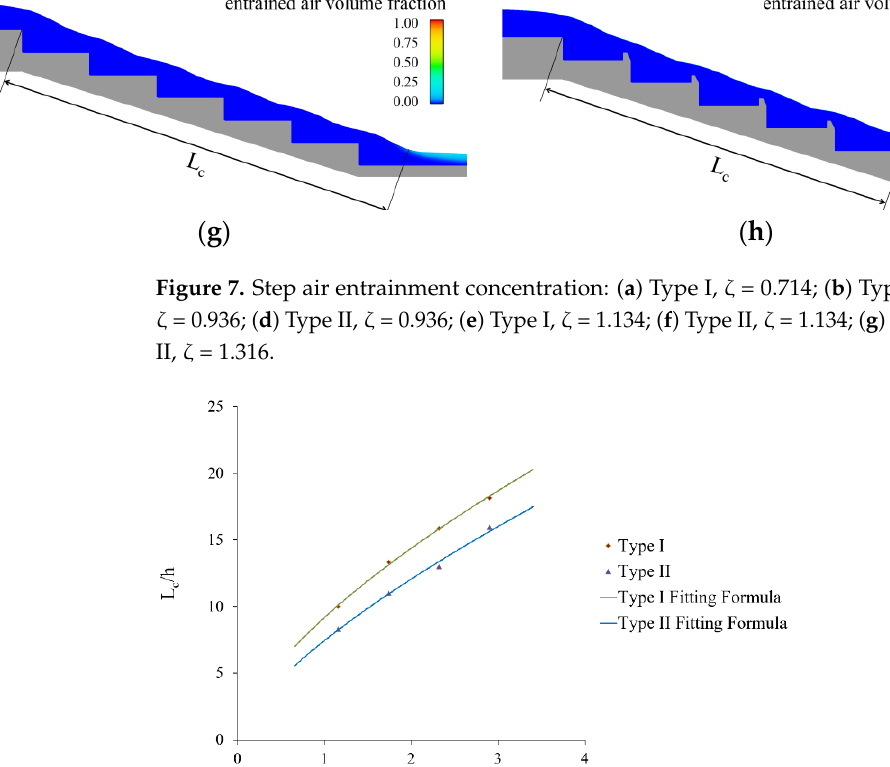
Figure 8. Step relative initial air entrainment point.